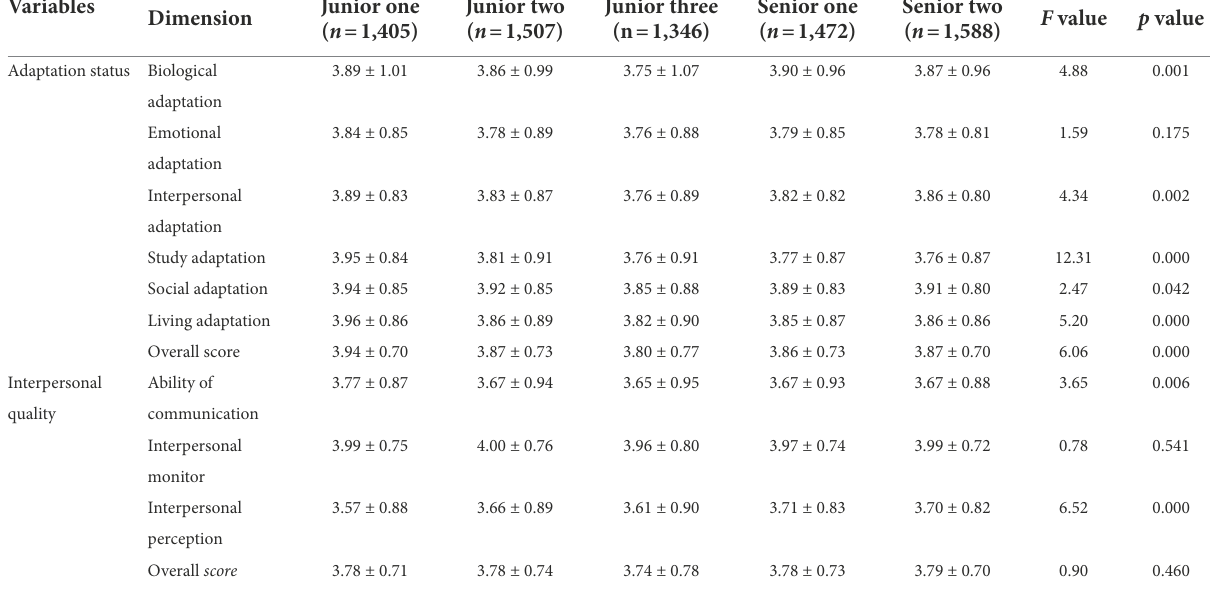
TABLE 1 Trends in adaptation and interpersonal quality of Chinese adolescents in post-epidemic era.